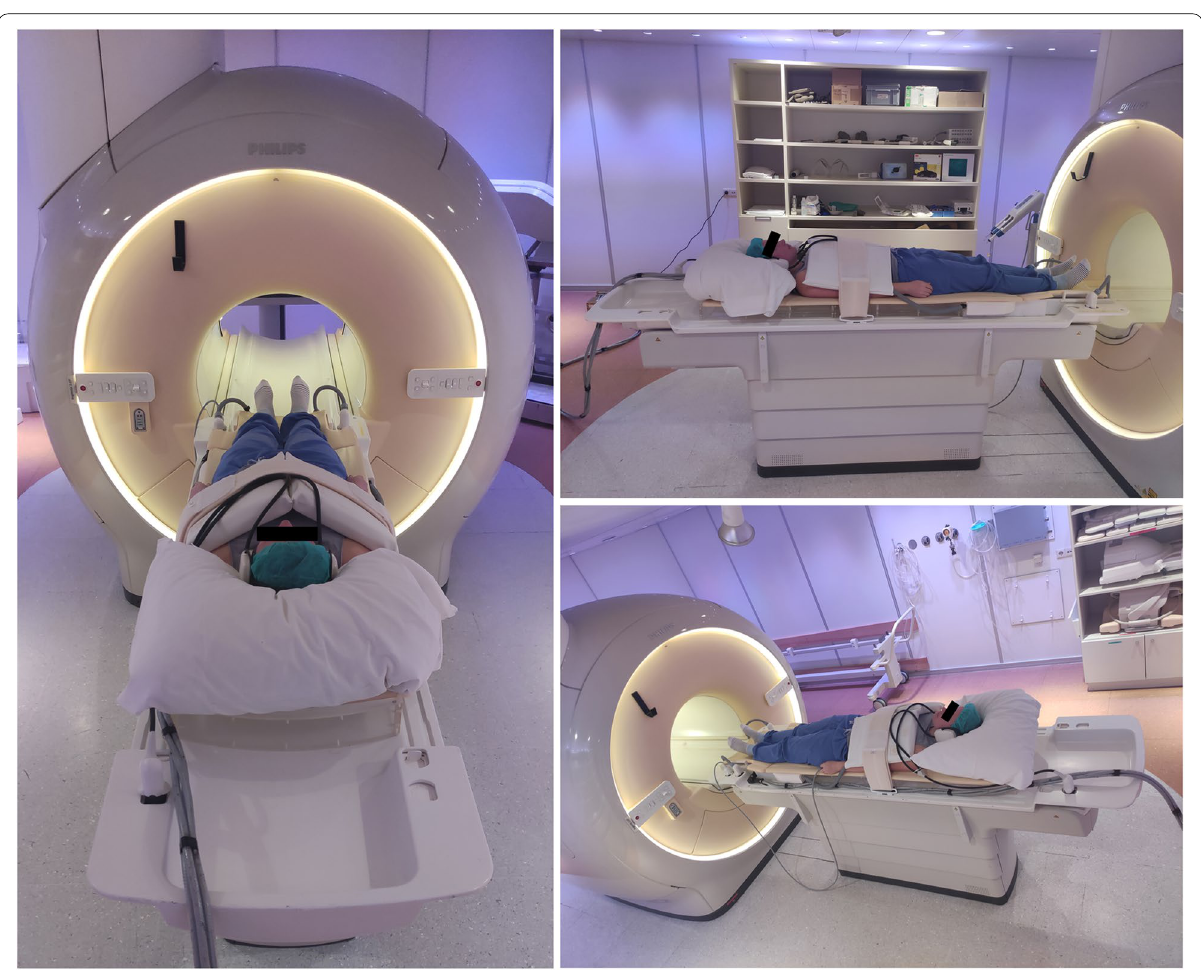
Fig. 1 Photograph of a subject on the scanner bed with the 72-channel cardiac receive array coil placed on the